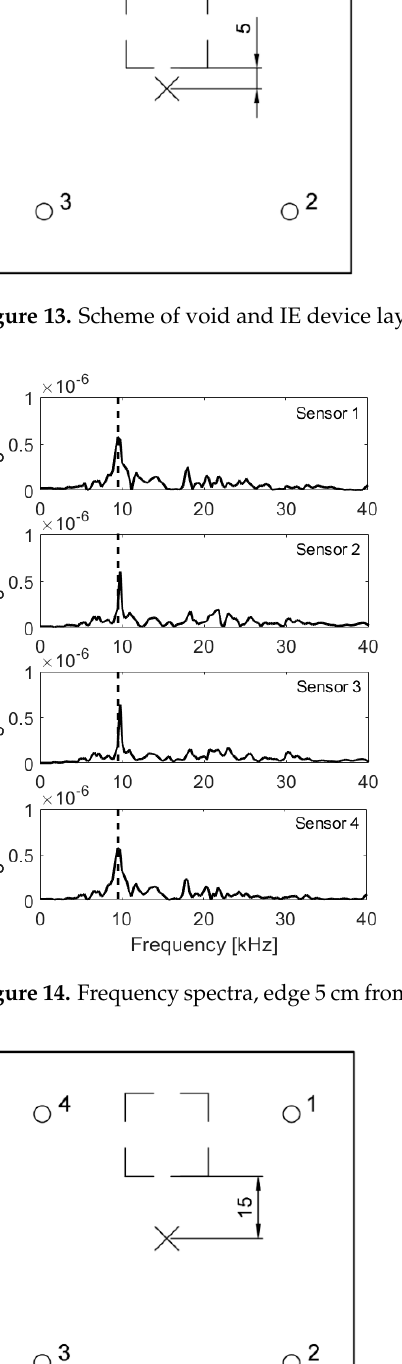
Figure 16. Frequency spectra, edge 15 cm from impactor; expected frequency marked with dashed line. Figure 17. RMS of signal received by each transducer with change of void edge distance from impact point.